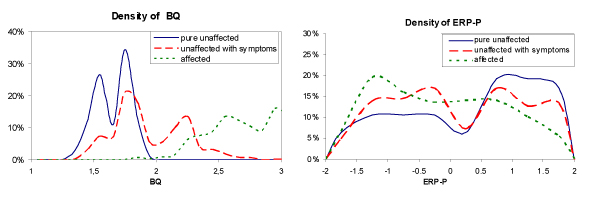
Density (kernel smoothed) of lnBQ and ERP-P scores of sibs.